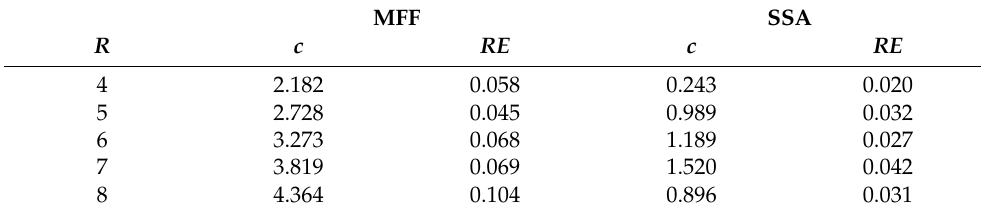
Table 3. Relative errors by comparing with the FEM.